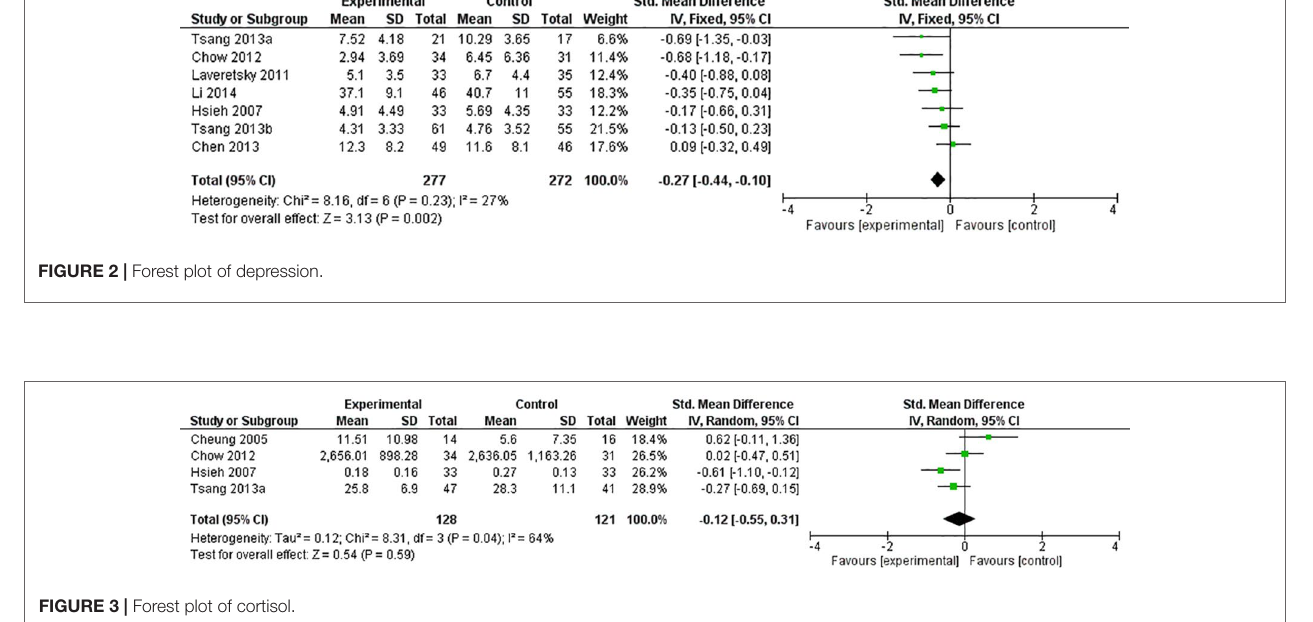
FiGURe 3 | Forest plot of